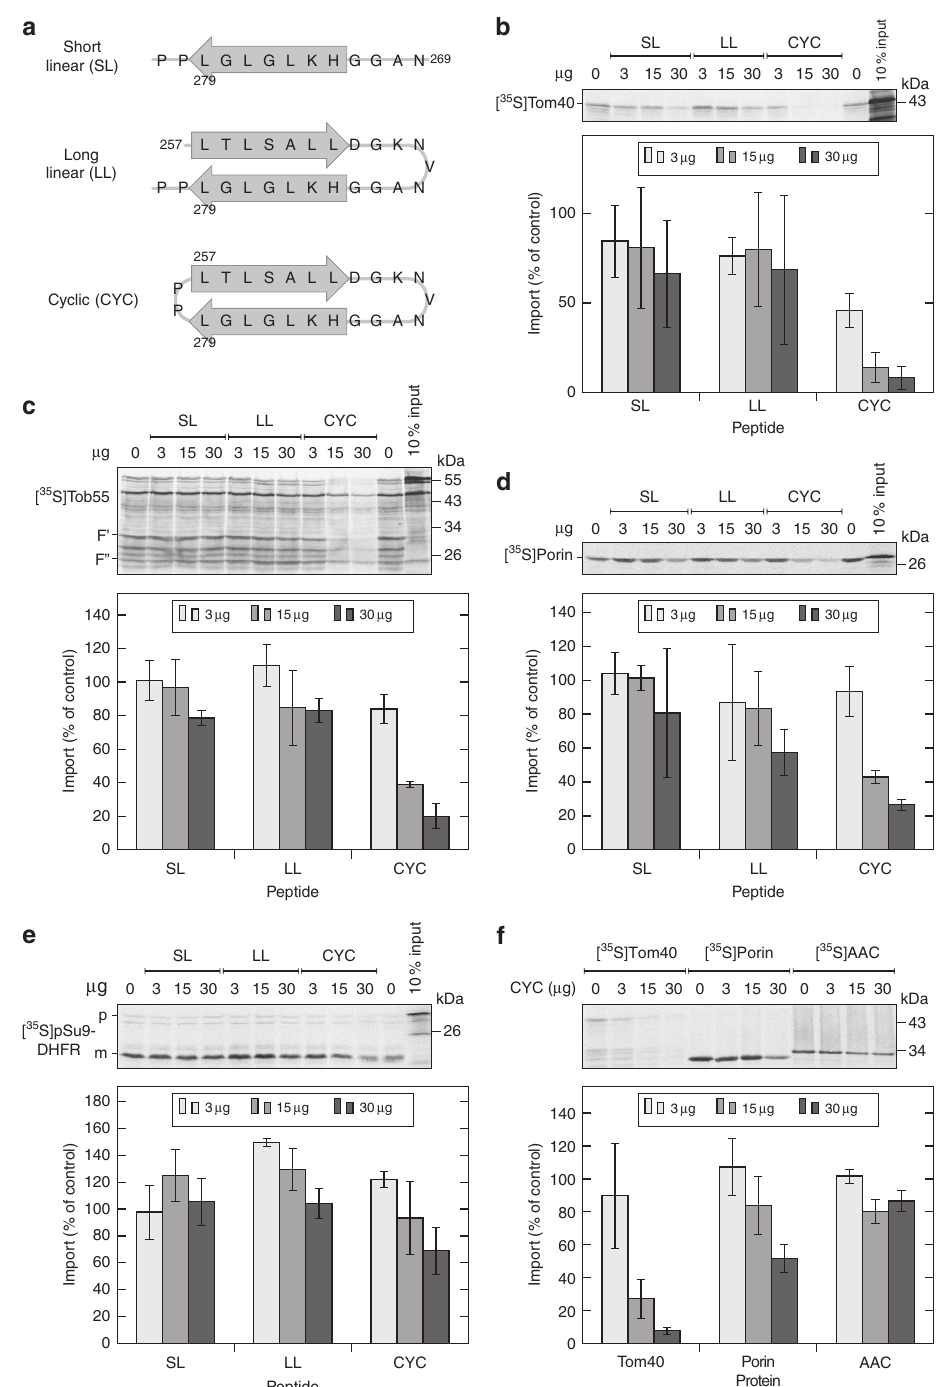
Figure 1 | A cyclic b -hairpin peptide inhibits the in vitro import of b -barrel proteins. ( a ) Schemes of the three peptides. Grey arrows indicate the residues that form a b -strand in full-length hVDAC1. Residue numbers correspond to the numbering of full-length hVDAC1. ( b – e ) Radiolabelled precursor proteins of Tom40 ( b ), Tob55 ( c ), Porin ( d ) or pSu9-DHFR ( e ) were mixed with isolated mitochondria in the presence of the indicated amounts of the short linear (SL), long linear (LL) or cyclic (CYC) peptide. In the end of the import reactions, samples were treated with proteinase K to degrade non-imported molecules. In the case of Tob55, this treatment led to the generation of two protease-protected fragments (F 0 and F 00 ) 27 . Samples were then subjected to SDS–PAGE and autoradiography (top panels). Bottom panels: the intensities of bands corresponding to the full-length form of Tom40 and Porin, the fragment F 0 of Tob55 or the mature form of pSu9-DHFR from three independent experiments were quantified and the mean intensity from the import without any peptide was set to 100%. Error bars represent standard deviation. The precursor and mature forms of pSu9-DHFR are indicated by p and m, respectively. ( f ) The indicated radiolabelled proteins were incubated with isolated mitochondria in the presence of various amounts of the cyclic peptide. The import reactions were analyzed as in parts ( b ) and ( d ). AAC, ADP-ATP carrier.